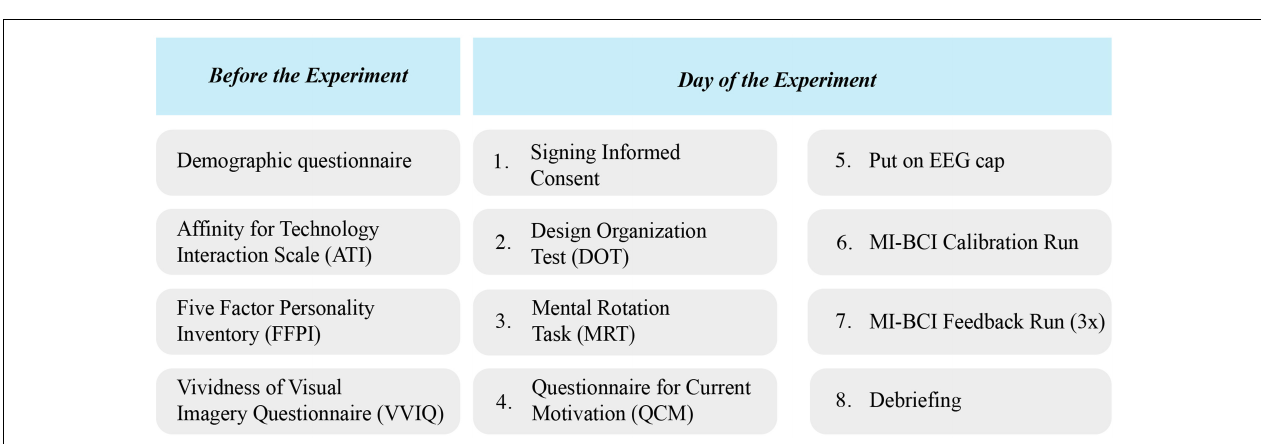
FIGURE 3 | The time course of trials in the BCI task (A) during the calibration run and (B) during the feedback runs. All trials started with a fixation cross and thereafter a red arrow indicated the direction of the motor imagery task (i.e., left or right). The participant had to imagine a movement for the corresponding hand. In the calibration run participants held motor imagery until the end of the trial. In the feedback runs, a feedback bar indicated the direction of the classifiers’ prediction. A blank screen indicated the end of the trial.